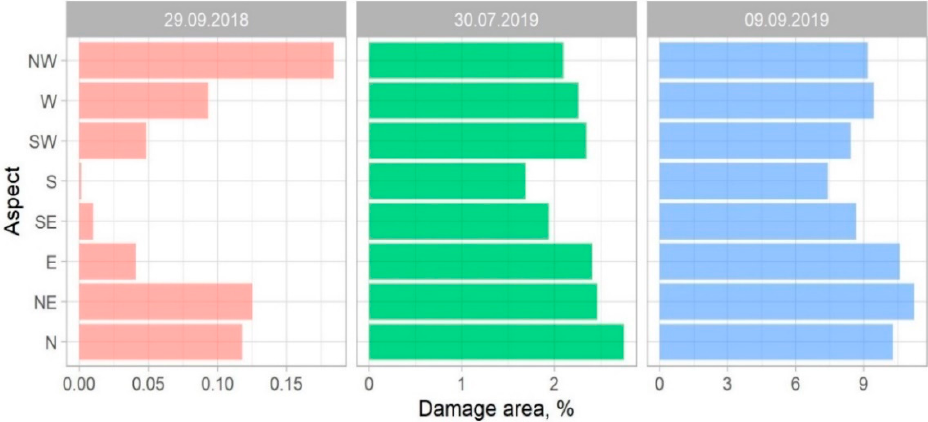
Figure 6. Dynamics of the area increase (%) of damaged dark coniferous stands depending on the slope aspect at a specific date. Table 5. Statistical indicators of damaged stand distribution depending on the slope aspect.